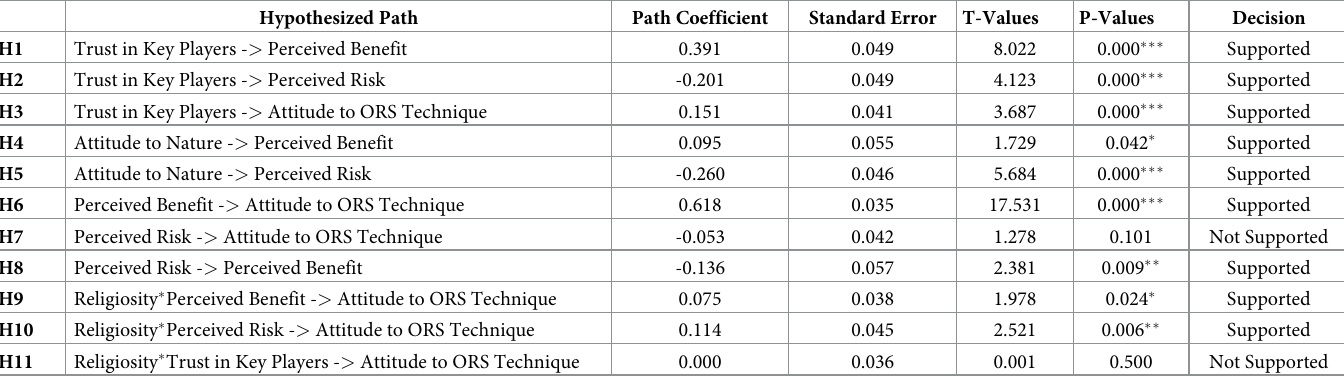
Table 7. The relationship predicting factors and moderator that influence attitude towards the ORS